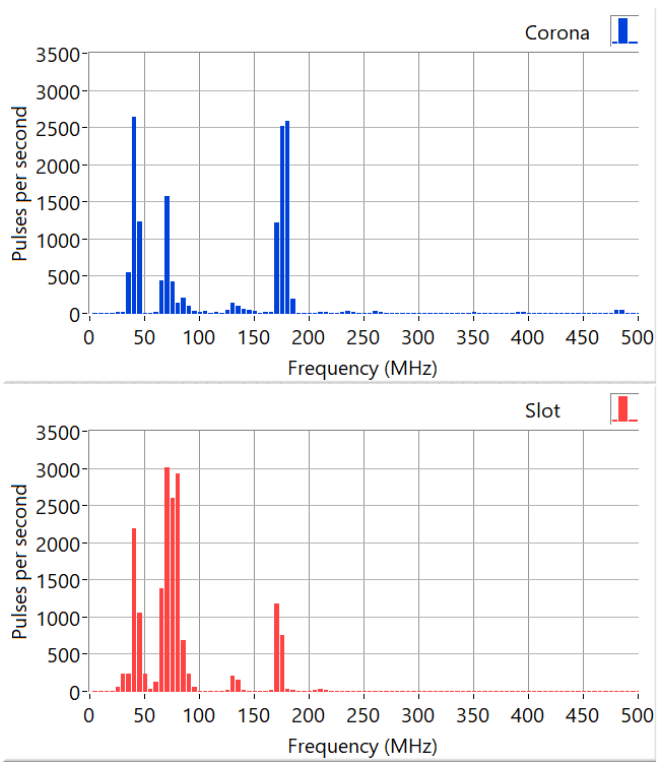
Figure 9. Spectral pulses per second registered in this work, during 150 s, for corona and slot